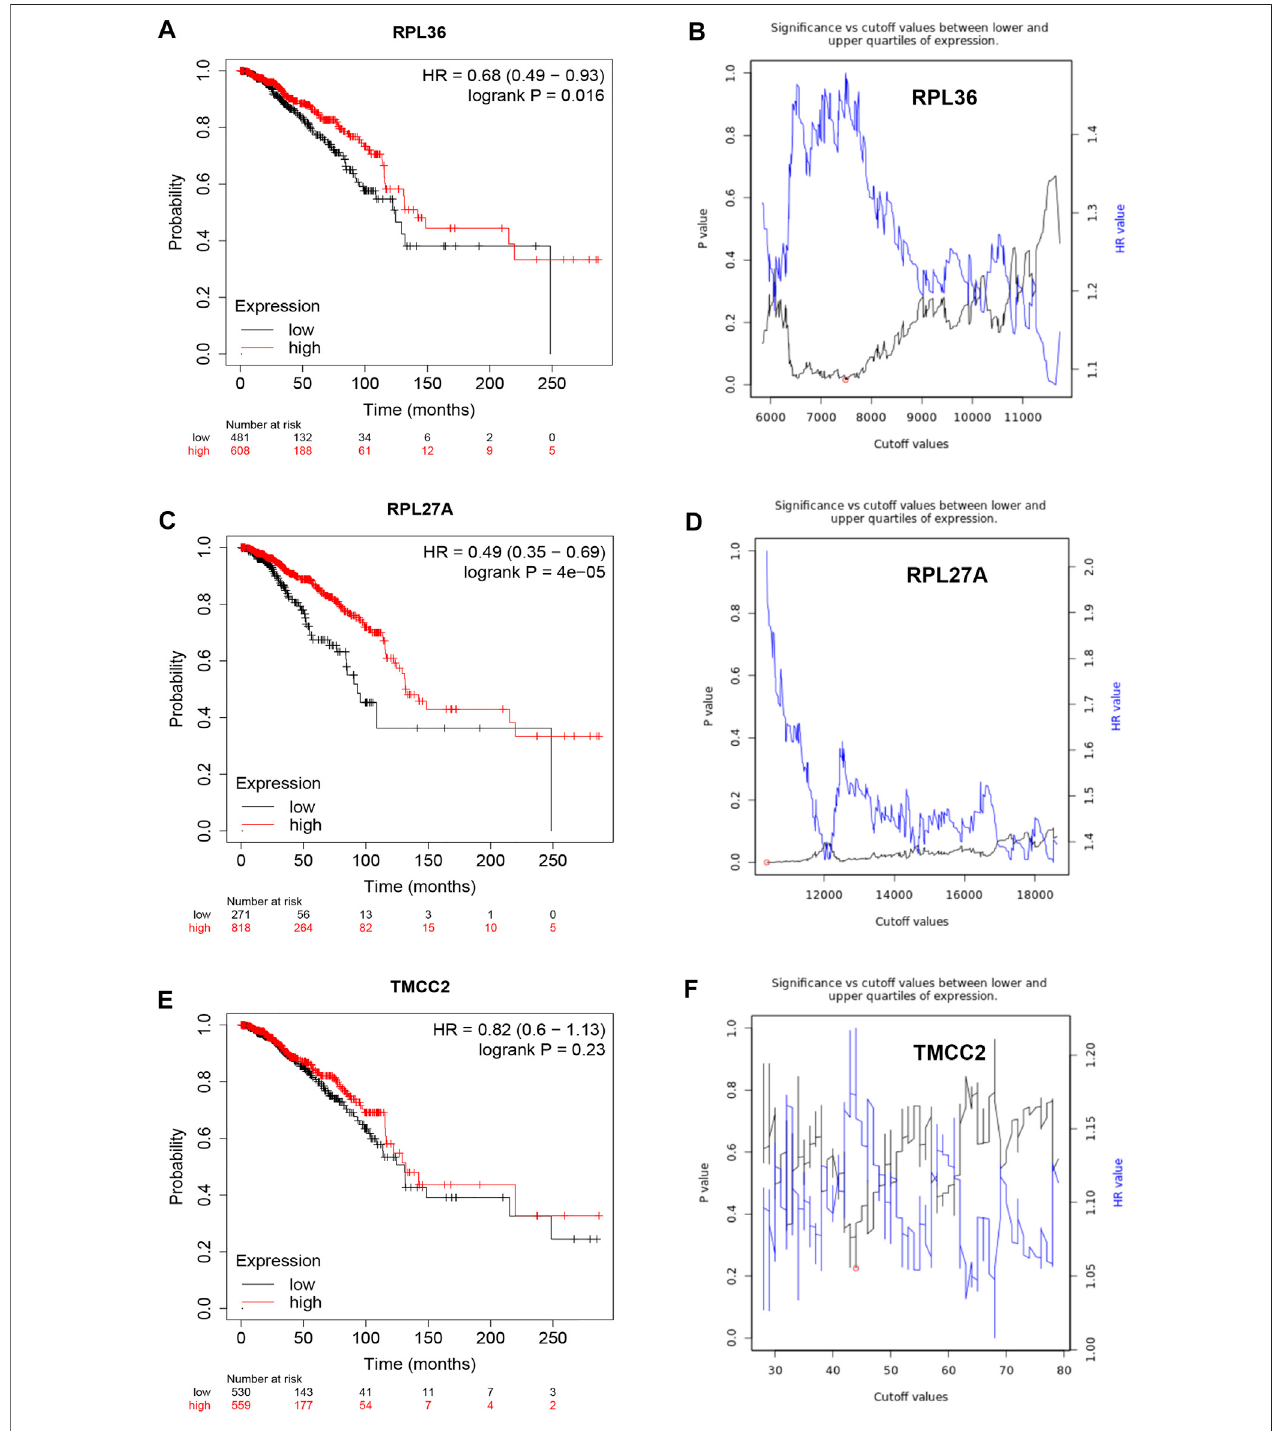
FIGURE 7 | Survival analysis for RPL36, RPL27A and TMCC2 in breast cancer. (A) The prognostic value of RPL36 in breast cancer. (B) The plot of signi fi cance versus cutoff values between lower and upper quartiles of RPL36 expression. (C) The prognostic value of RPL27A in breast cancer. (D) The plot of signi fi cance versus cutoff values between lower and upper quartiles of RPL27A expression. (E) The prognostic value of TMCC2 in breast cancer. (F) The plot of signi fi cance versus cutoff values between lower and upper quartiles of TMCC2 expression.